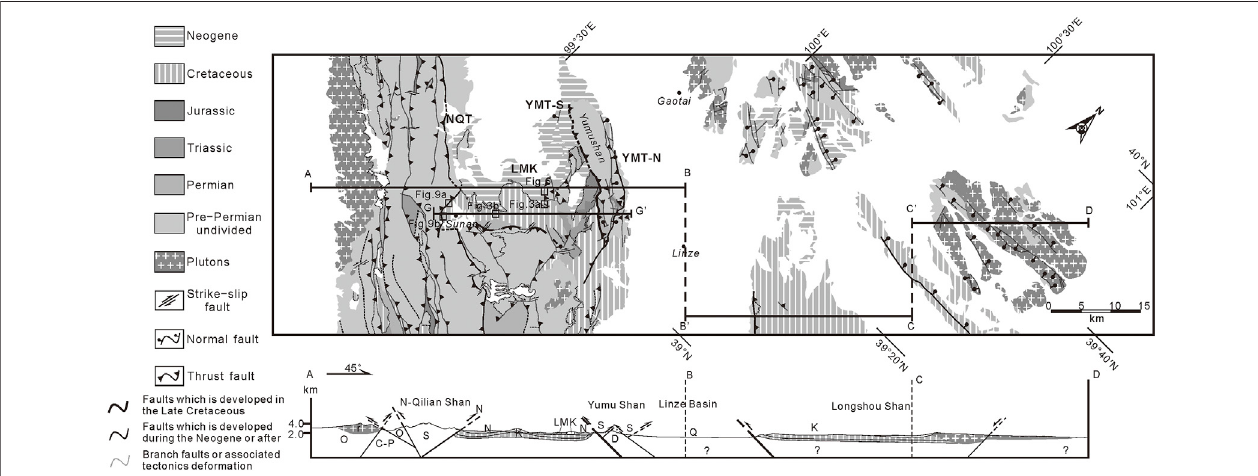
FIGURE 4 | Field map of the Sunan area. (Map based on data from the Bureau of Mineral Resources of Gansu Province (BMRGP, Regional Geological Survey) (1982), BMRIMP (1991), Bureau of Mineral Resources of Qinghai Province (BMRQP, Regional Geological Survey) (1991) and fi eldwork conducted for this study).